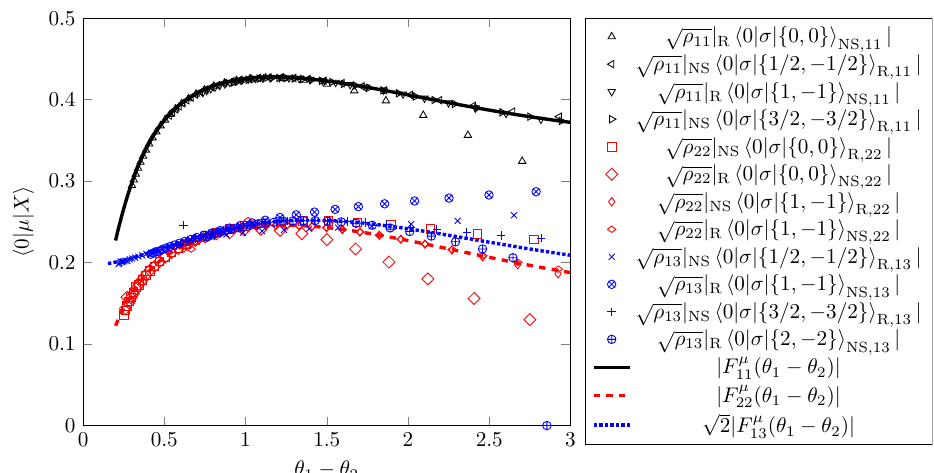
Figure 6.5: Rescaled vacuum-two-particle matrix elements of σ coming from TCSA in the low temperature phase plotted against the rapidity difference using discrete markers, and compared to form factors of µ in the high temperature phase shown with lines. The R / NS index corresponds to the sector from which the two-particle state is extracted; the vacuum state is always the ground state of the other sector. As discussed in Appendix C.2, the main source of error in this comparison are the expo- nential finite volume corrections to the matrix elements. States with larger Bethe– Yang quantum numbers realise the same rapidity difference in the larger volume, leading to smaller finite size corrections in this